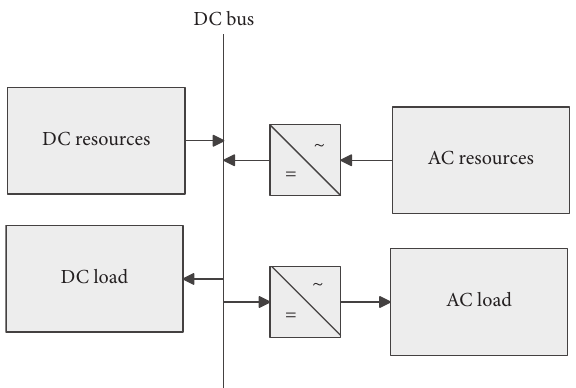
Figure 3: Centralized DC bus configuration.